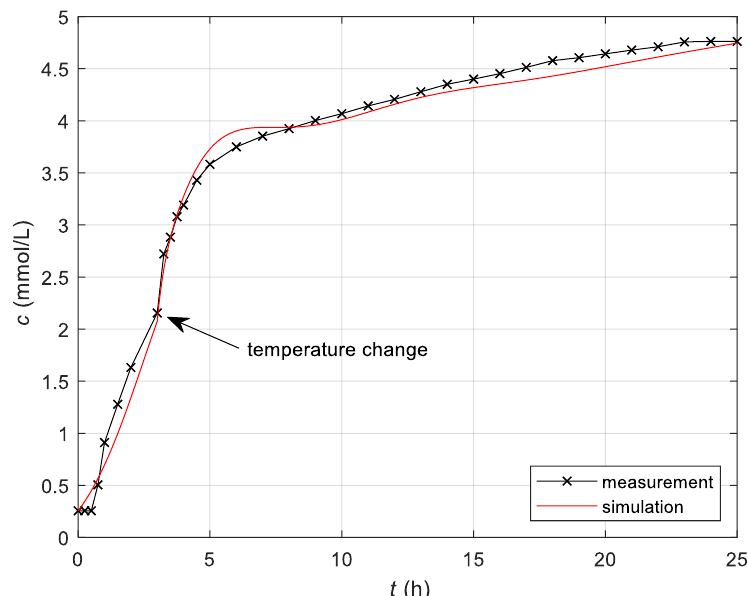
Figure 5. Time courses of dissolved CO 2 concentration c obtained by measurements in laboratory bioreactor and simulation with the identified Complete model. The analyzed fermentation process was carried out in a time range from t = 0 to t = 3 h at temperature 22 °C, and from t = 3 h to t = 25 h at temperature 27 °C.